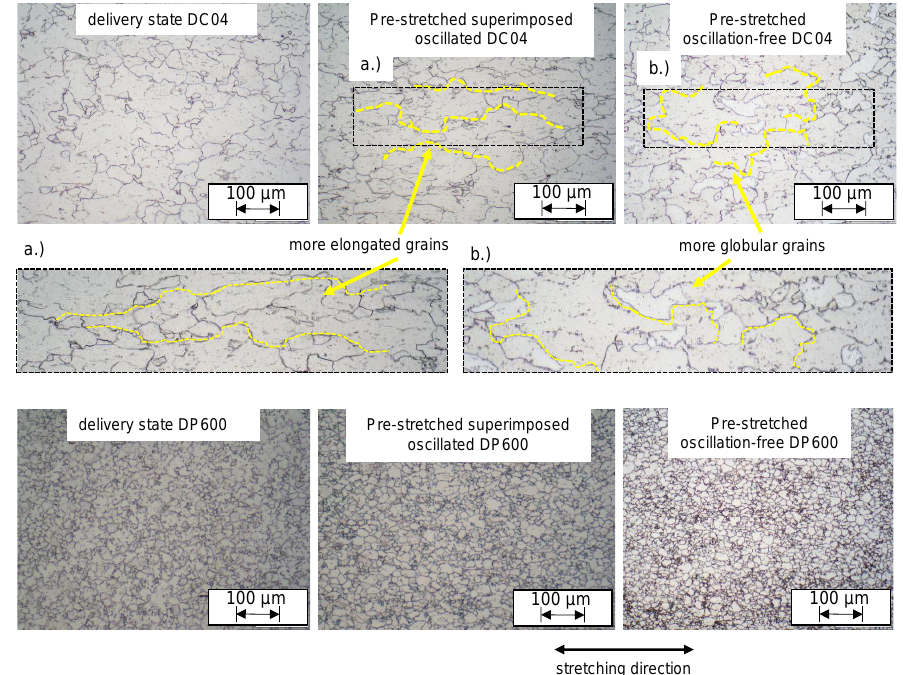
Figure 5. Micrographs for superimposed oscillation and oscillation-free pre-stretched and non-pre- stretched tensile test specimen.